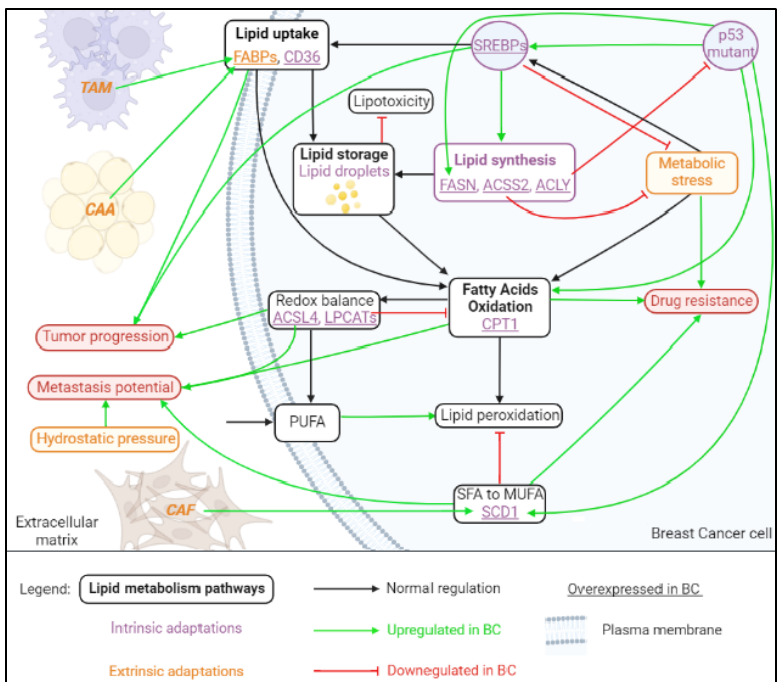
Figure 2. Known lipid metabolism adaptations in BC cells. Breast cancer cells can develop and un- dergo adaptation of their diverse lipid metabolic pathways to cover their high needs for energy and biomass synthesis. Main proteins responsible for these metabolic changes are depicted here and are deciphered as intrinsic proteins (in purple) or derived from the TME (in orange). Major effects of lipid metabolic pathways on BC progression are indicated by green arrows. Metabolic stress in- cludes nutrient deprivation, hypoxia and endoplasmic reticulum stress. Upregulated and downreg- ulated pathways described above illustrate an inherent large heterogeneity of lipid metabolism